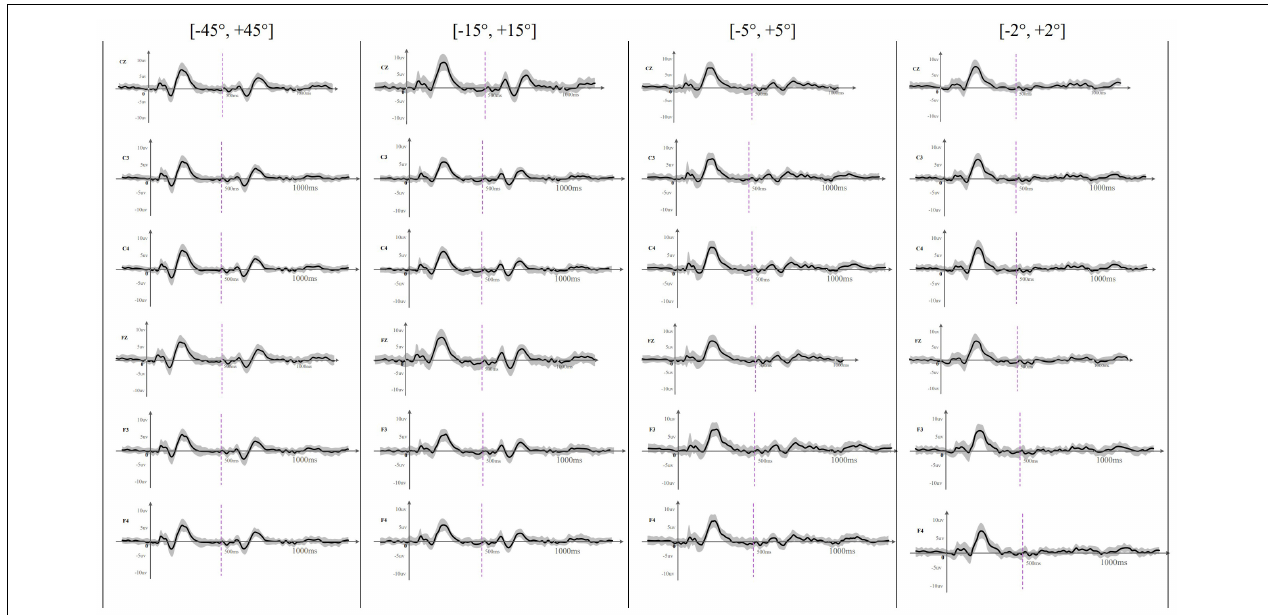
FIGURE 2 | The averaged ( n = 33) waveform at all recording electrodes elicited by rightward location change in different test angles. This figure showed the averaged waveform obtained at Cz, C3, C4, Fz, F3, and F4 across different location change angles. The sound location change happened at 500 ms and was indicated by a purple dotted line. The SD of each averaged waveform was plotted in a gray area. Onset-CAEP appeared within 50–250 ms and ACC appeared within 600–800 ms except that ACC waveform was difficult to judge at [–2 ◦ , +2 ◦ ].